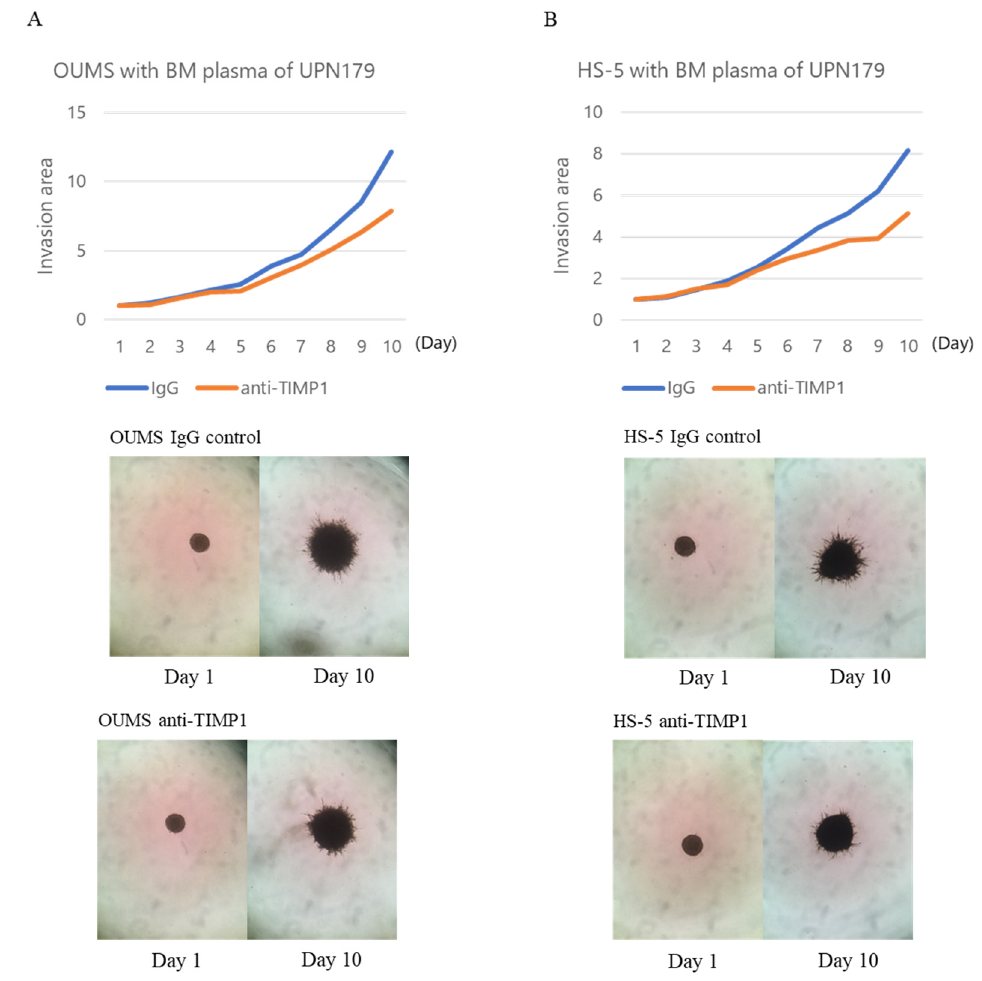
Figure 6. Invasive capacity of ( A ) OUMS-36T-3F and ( B ) HS-5 cells incubated with BM plasma and IgG control or neutralizing anti-TIMP1 antibodies. Blue line, IgG control; orange line, anti-TIMP1 antibodies. Representative images of OUMS-36T-3F and HS-5 cells cultured with BM plasma from patient UPN179 at diagnosis (TIMP1 protein level: 413.71 ng/mL) with IgG control or anti-TIMP1 antibodies.